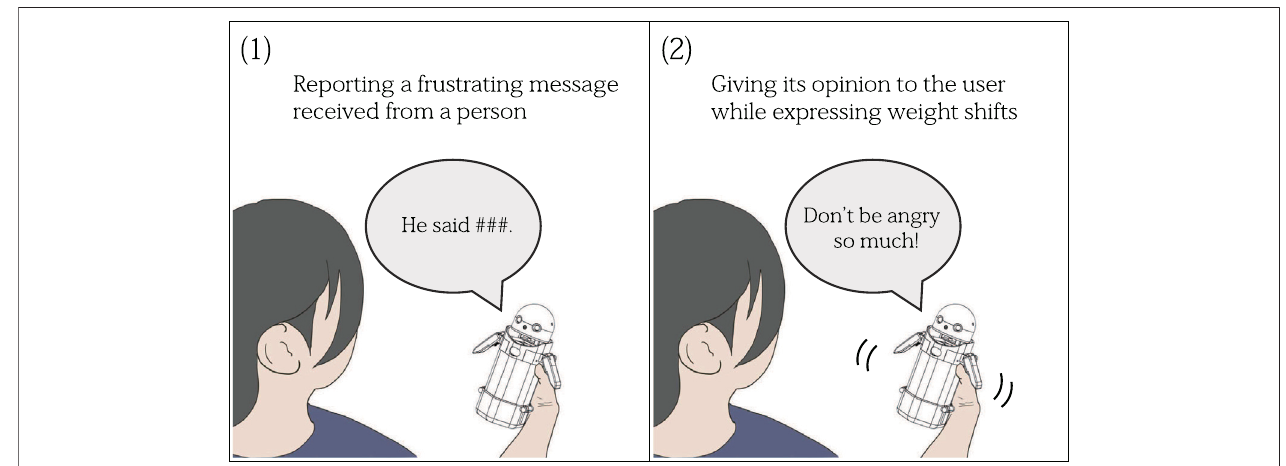
FIGURE 1 | Robot intervention. A mediator robot reports a frustrating message received from a person followed by giving its opinion. The robot can also express internal weight movements (weight shifts). By expressing appropriate weight shifts along with its speech, we hypothesize that the serious intention of the robot can be enhanced, thereby in fl uencing the user ’ s negative affective